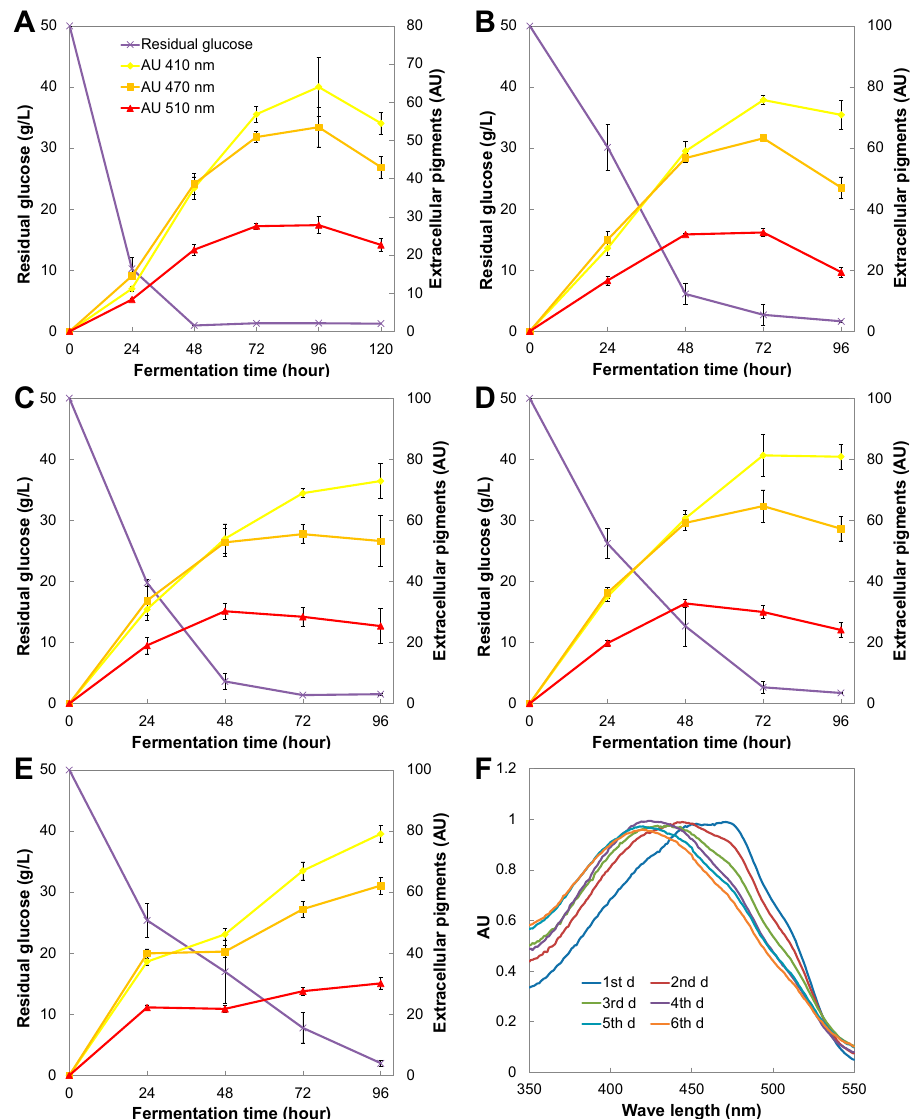
Figure 4. Extracellular pigment production and glucose consumption in repeated-batch extractive fer- mentation with immobilized cells. ( A ): First batch; ( B ): second batch; ( C ): third batch; ( D ): fourth batch; ( E ): fifth batch; ( F ): visible spectrum shift of extracellular pigments in the process of the first